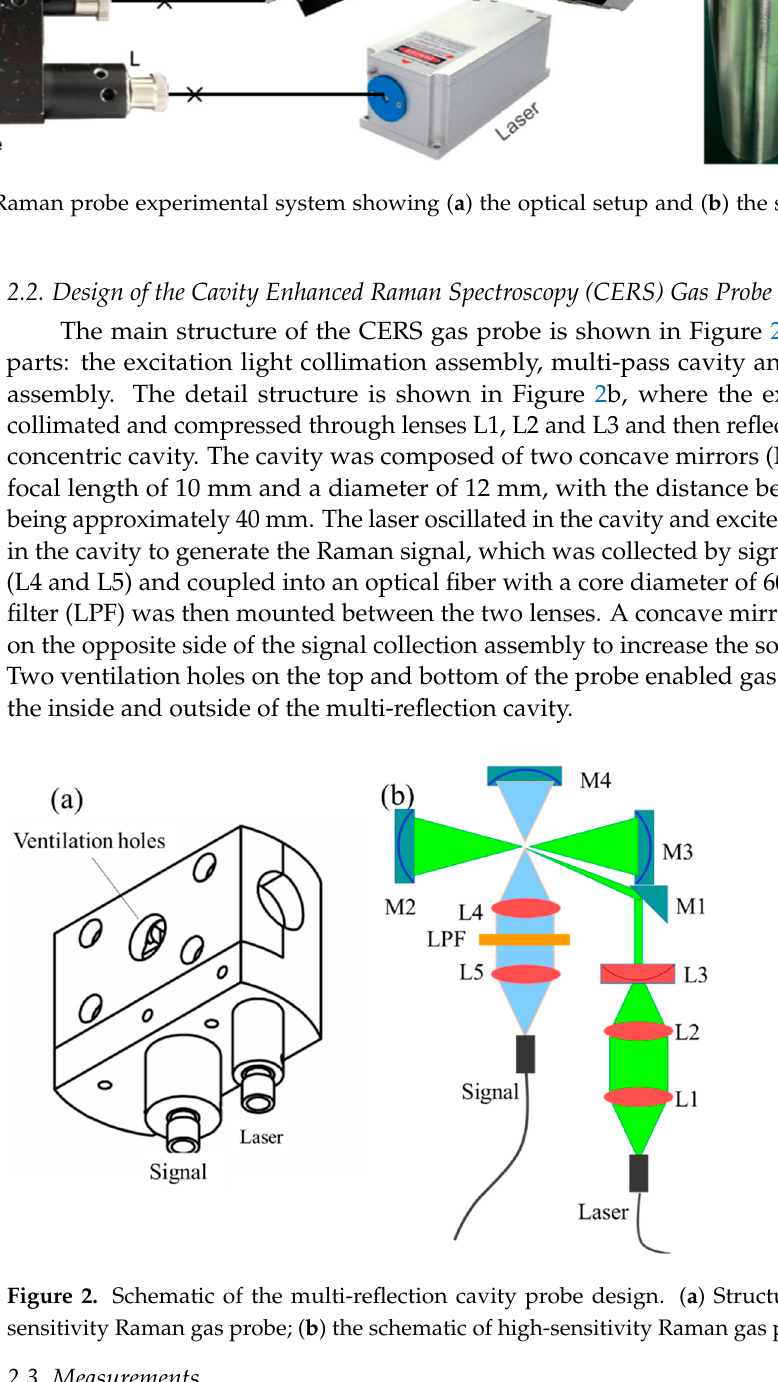
Figure 2. Schematic of the multi-reflection cavity probe design. ( a ) Structure drawing of high-sen- sitivity Raman gas probe; ( b ) the schematic of high-sensitivity Raman gas probe.